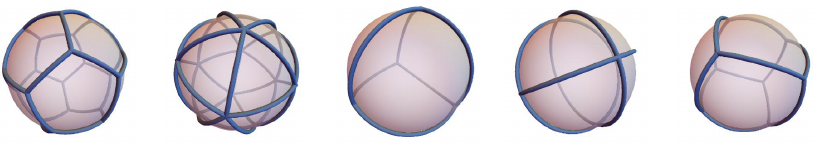
Figure 2. The embeddings of the skeletons of Platonic solids on the unit